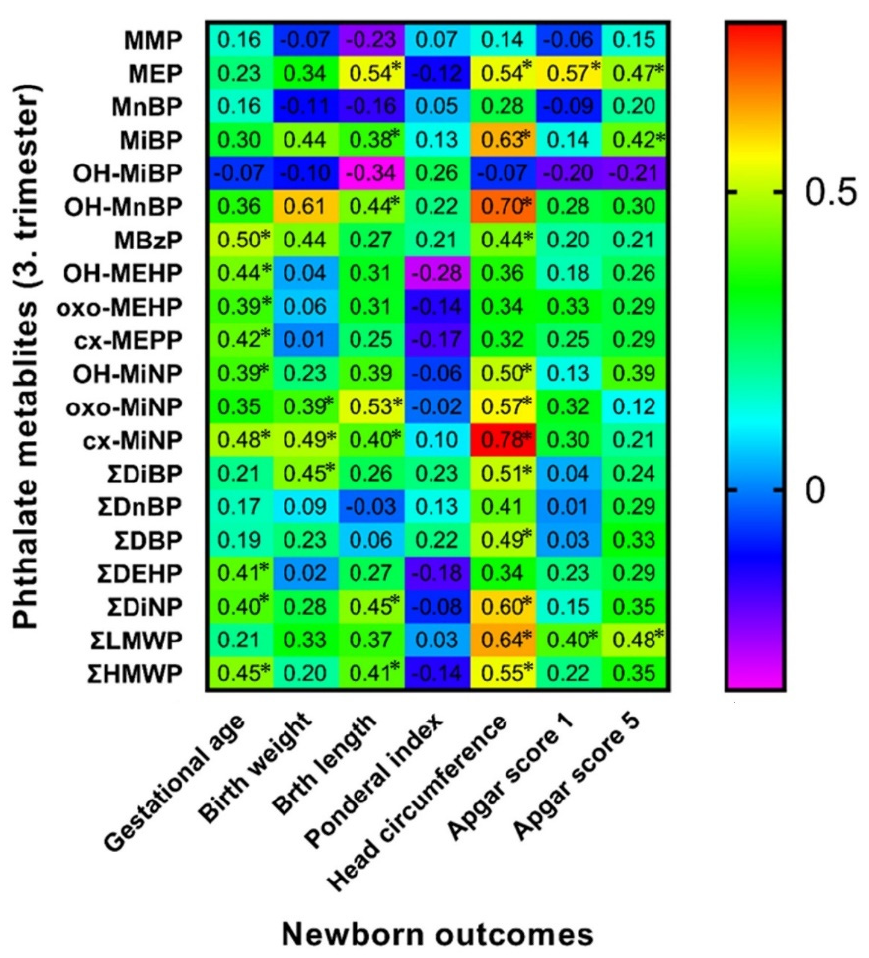
Figure 6. Correlation matrix of girl-newborn outcomes and maternal phthalate metabolites during third trimester of pregnancy. Legend is shown in the footnote of Table 4. * The correlation is significant at the level p ≤ 0.5.